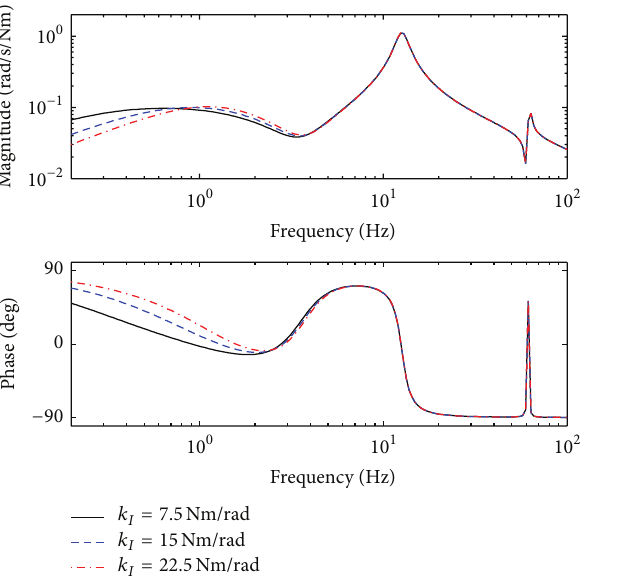
Figure 5: Sensitivity analysis results: effect of the integral gain of the PI speed controller on the FRF